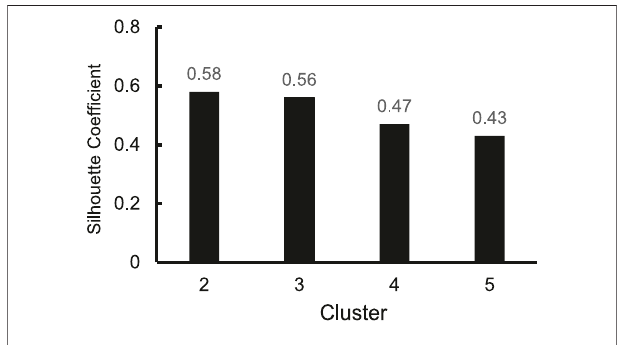
FIGURE 2 | Silhouette coef fi cients of various clustering